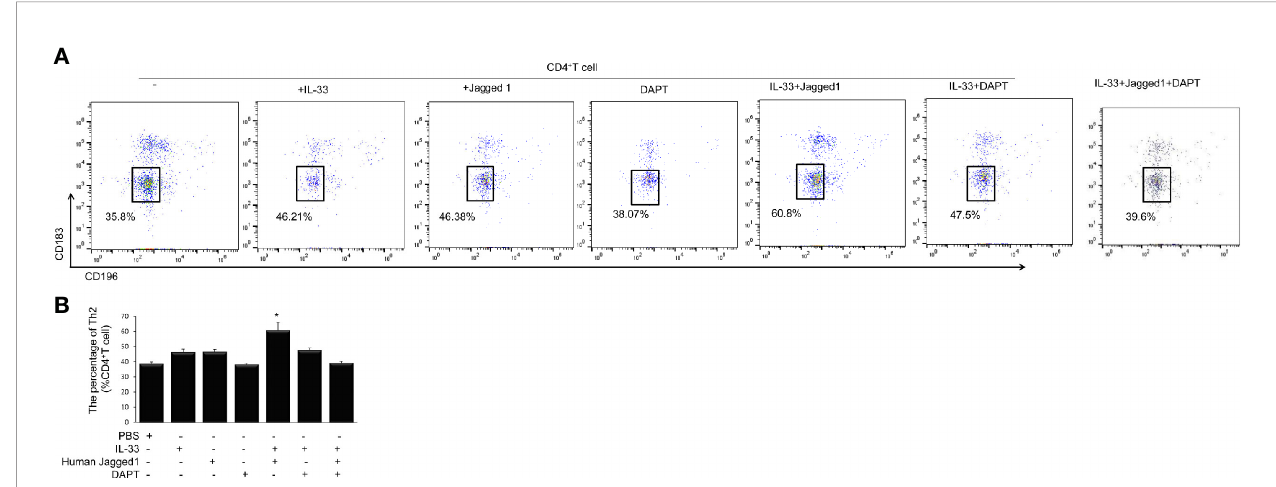
FIGURE 6 | Th2 cells after treatment in different groups. Level of Th2 cells after treatment with the supernatant of PBS group, IL-33 stimulation group, Jagged 1 treatment group, DAPT treatment group, IL-33 + Jagged 1 treatment group, IL-33 + DAPT treatment group was determined by fl ow cytometry. (A) Th2 (CD183 − CD196 − ) was labeled with speci fi c antibodies and quanti fi ed in each treatment groups. (B) Percentage of Th2 cells. Data are shown as mean ± SEM. n=10.* P < 0.05 compared with CD4 + T cell